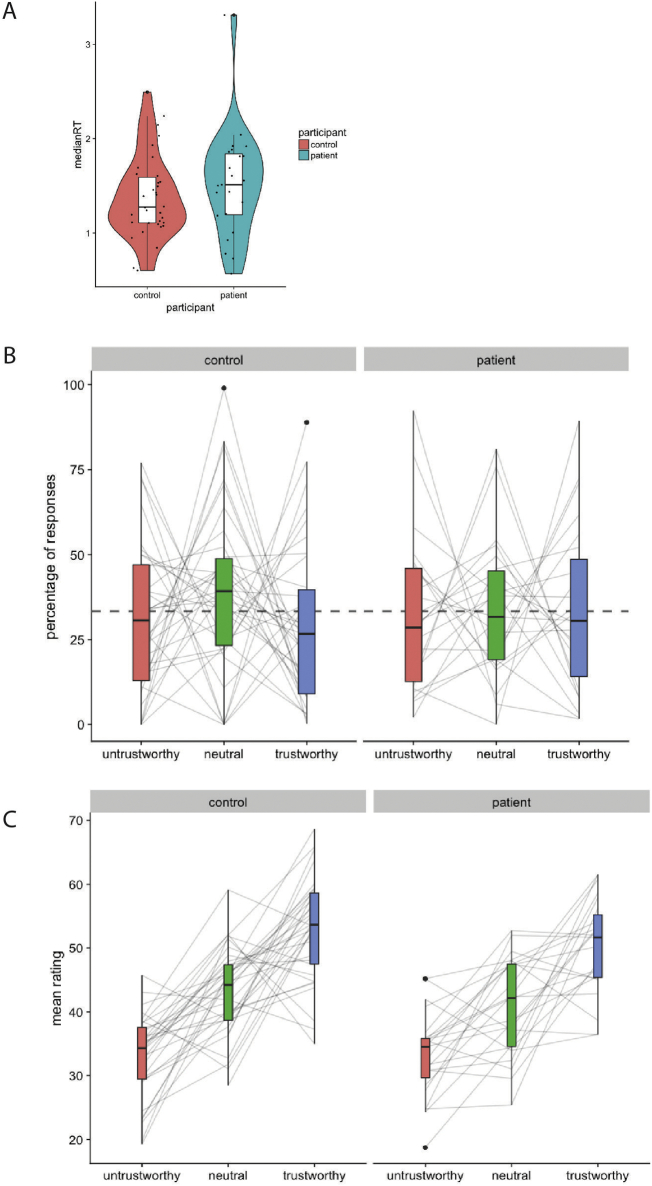
(A) Median response times per participant, for patients (right, light blue) and controls (left, ref). Dots reflect median response times for individual participants, with random jitter on the x-axis, to increase visibility of individual dots. Outlines of the violin plots represent the density distributions of the samples and are overlaid with boxplots. (B) Percentage of responses for each of the three response categories (untrustworthy: red; neutral: green; trustworthy: blue), for controls and patients (left and right panels, respectively). Grey lines represent the percentage of responses for individual participants. Dashed horizontal line represents a uniform distribution of responses (33%). (C) Subjective ratings of classification images on trustworthiness (scale 1–100) by a sample of independent raters, for controls (left panel) and patients (right panel). Colours depict the response category of the classification image (untrustworthy: red, neutral: green, trustworthy: blue). Grey lines represent the ratings of individual classification images.